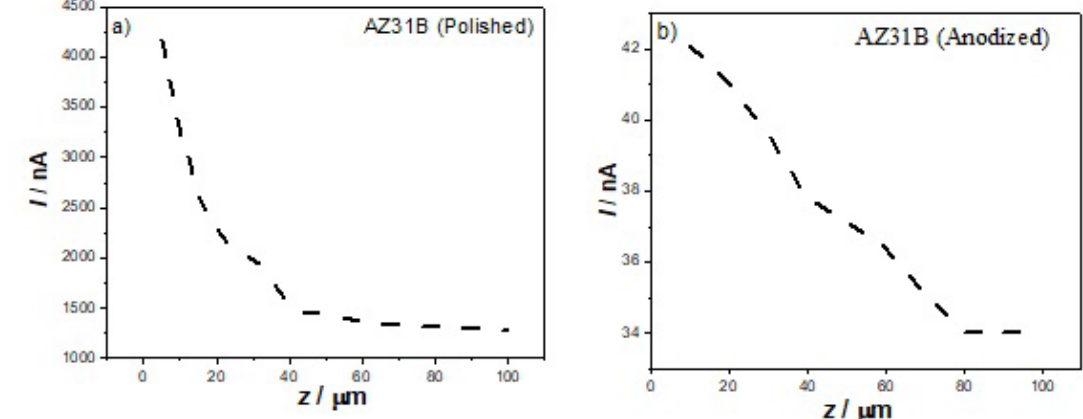
Figure 4. Z-Approach curves for a 25 µm Pt UME biased at 0.0 V on the AZ31B alloy at the OCP: polished (a) and anodized (b) conditions in SBF solution. The Z-Approach curves were acquired after 20 minutes of immersion at a scan rate of 5 µm s -1